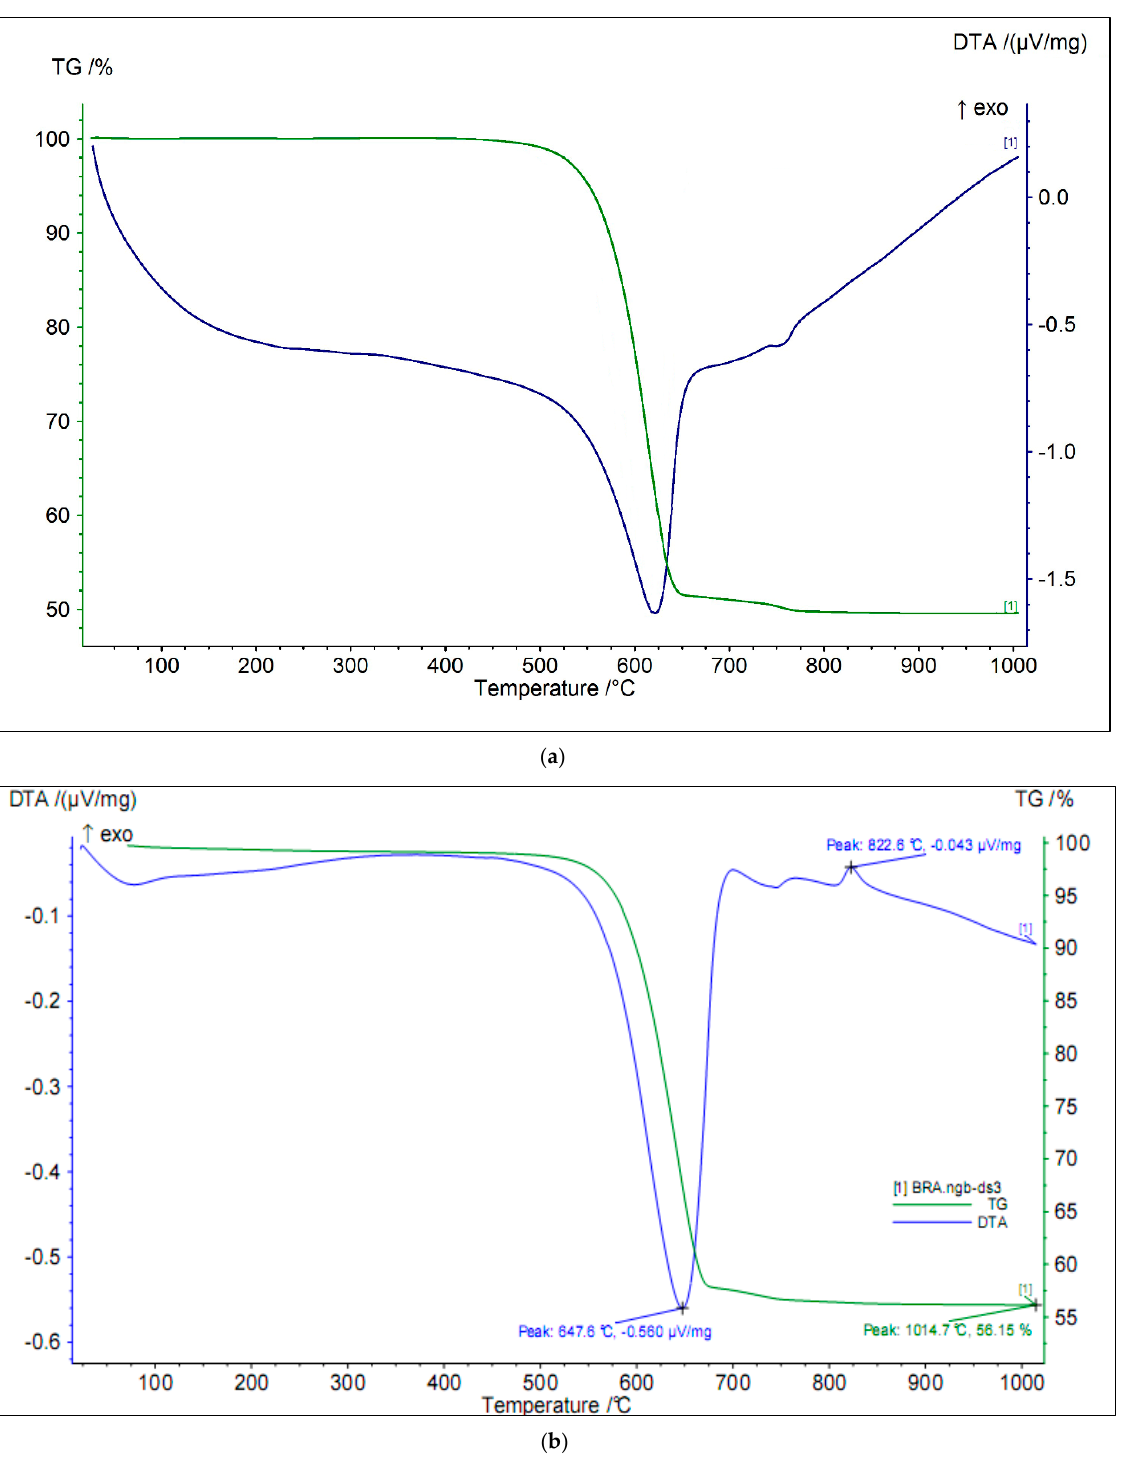
Figure 9. Thermal curves (DTA and TG), showing the course of the magnesite thermal dissociation process: ( a ) from the Wiry deposit; ( b ) from the Braszowice deposit.